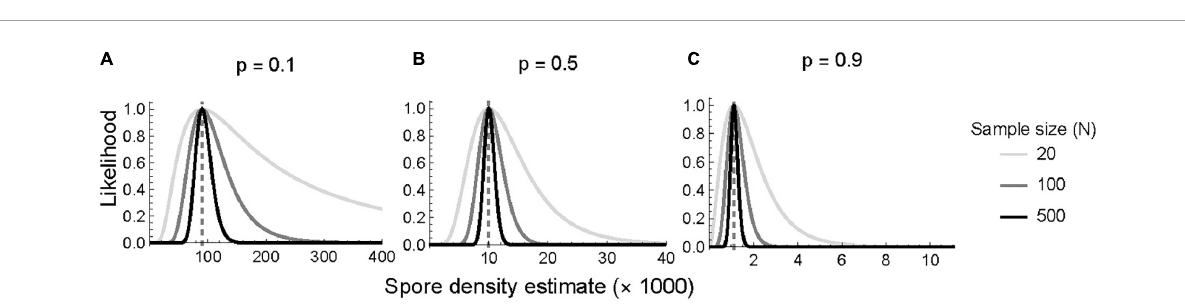
FIGURE2 Likelihood function of spore concentration if the proportion of tracers in the total sample are (A) rare 0.1, (B) equally frequent 0.5, and (C) abundant 0.9 in panels (A–C) . The vertical dashed line denotes the maximum-likelihood estimate of the concentration of spore in the sample. Light gray, gray, and black represent total count of 20, 100, and 500. Ten thousand tracers were added in each case.